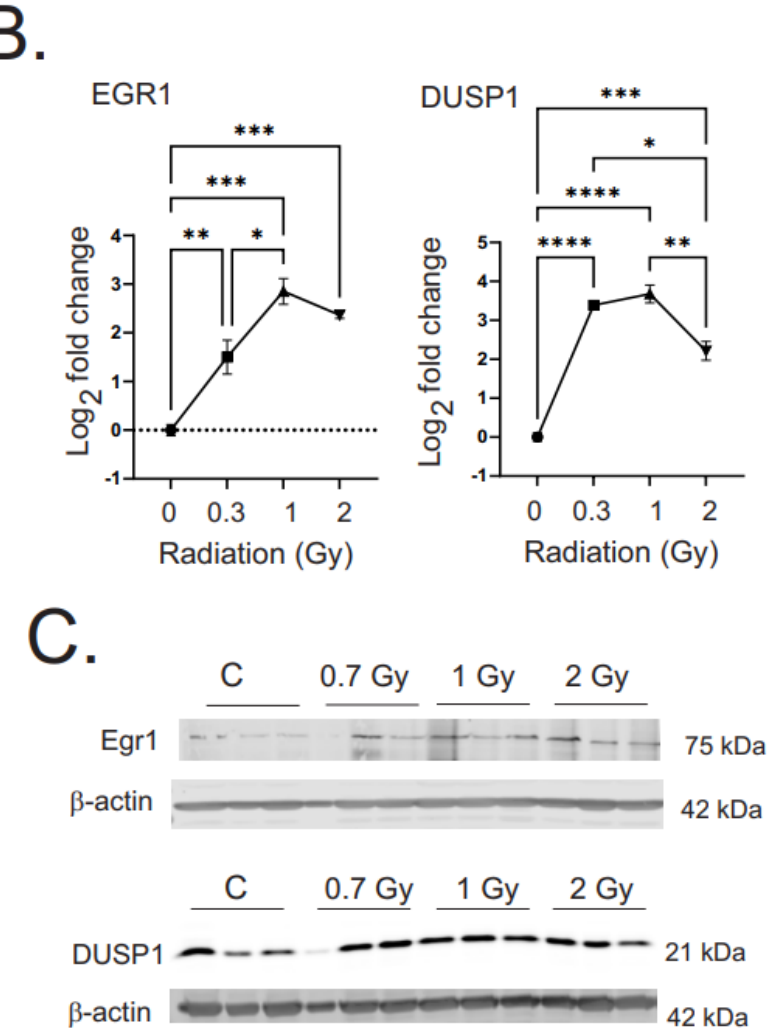
Figure 6. Heatmaps of gene expression changes for pathways in regulation of apoptosis, cell death, and autophagy. ( A ). RNAseq was used to identify gene expression changes in primary human MSCs following 1 or 2 Gy (0.66 cGy/h) 60 Co irradiation. Control cells were cultured under identical conditions for 1 or 2 weeks. GO analysis was performed using DAVID and heatmaps were generated using genes with q < 0.05. Rows are centered and unit variance is applied to rows. ( B ). qPCR gene regulation using log base 2 scale fold change of genes supporting heatmaps of pathways. Data show averages ± SEM from N = 3 biological replicates with two technical repeats. * indicates p < 0.05, ** indicates p < 0.01, *** indicates p < 0.001, **** indicates p < 0.0001, respectively, compared with sham-irradiated control cells. ( C ). Western blot data showing regulation of Egr1 and DUSP1. Western blots were performed on N = 3 biological repeats. Bar graphs show average band densities normalized to β -actin.